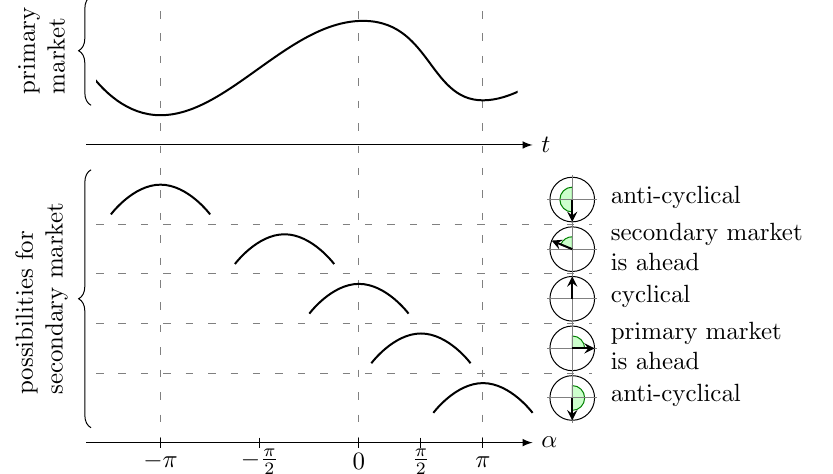
Figure 3. Computation of α in (2): The upper chart shows an idealized price movement of the primary market with two minima and one maximum; the lower part shows five different possibilities for the position of a maximum of the second market, where α the extreme values of the primary